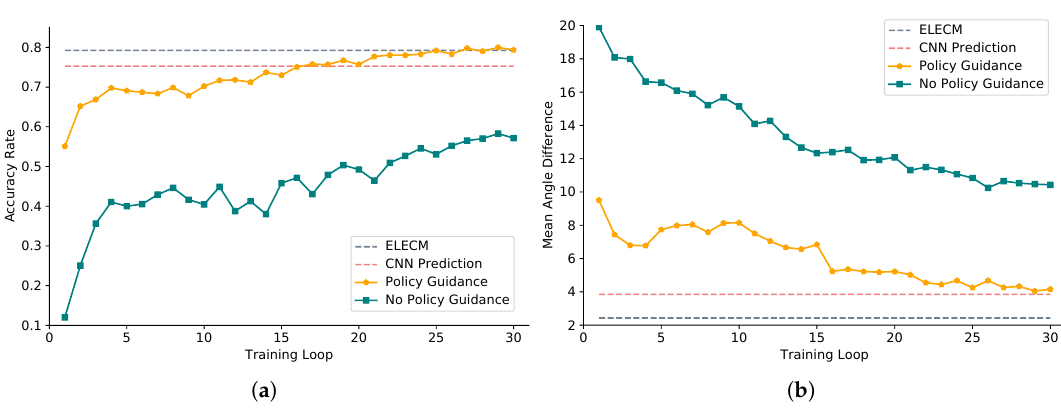
Figure 11. Prediction performance of Eigenvectors with the Largest Eigenvalue of Covariance Matrix (ELECM), Convolutional Neural Network (CNN), Agent with policy guidance and Agent which has no guidance. ( a ) accuracy rate lines of four models at different training loops; ( b ) mean angle difference ( ◦ ) lines of four models at different training loops.